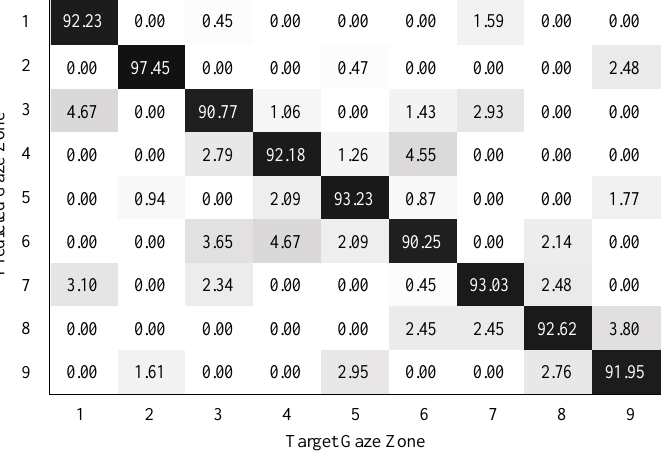
Figure 11. Gaze zone classification results based on the POSIT method and SVM classifier.